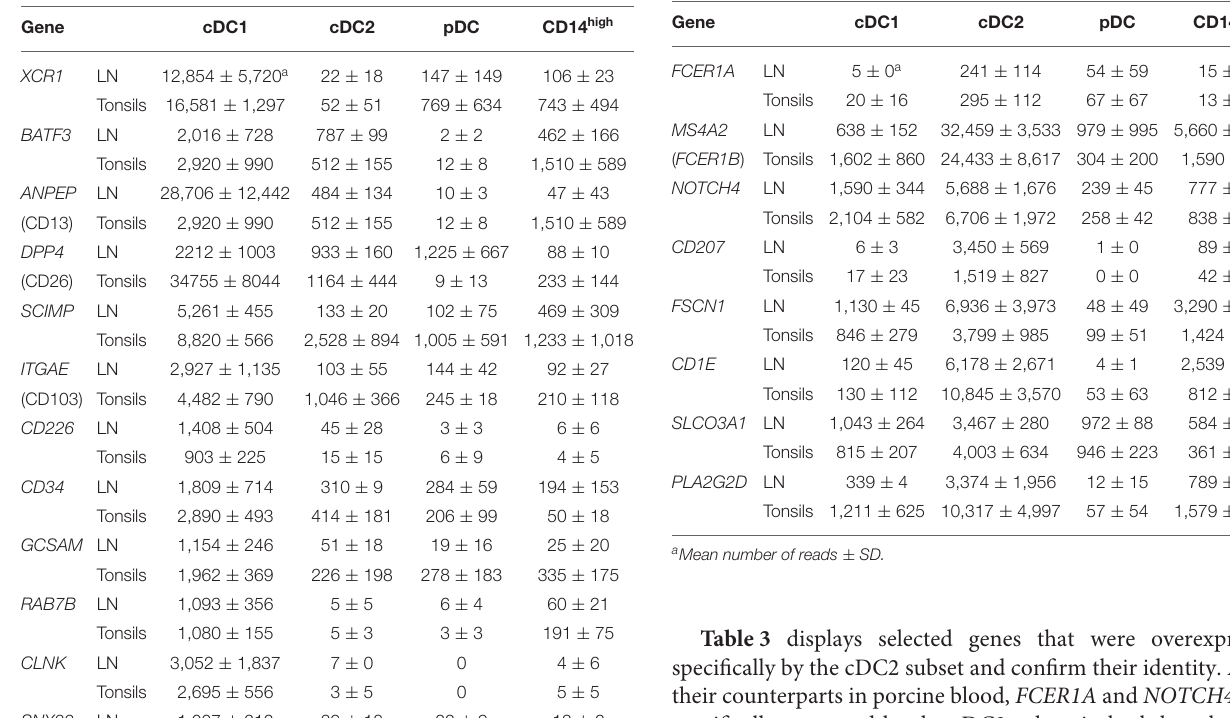
TABLE 2 | Differentially regulated genes in cDC1. TABLE 3 | Differentially regulated genes in